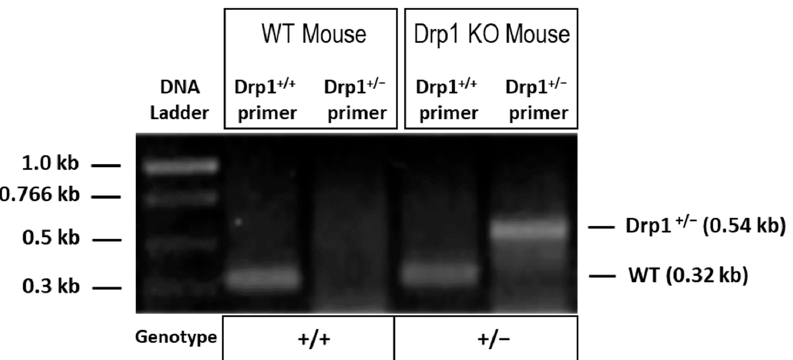
Figure 1. PCR analysis using mice tail tip DNA indicating genotypes of Drp1 heterozygous knockout ( +/ − ) and wild-type (WT) mice. The wild-type Drp1 allele (Drp1 +/+ ) is represented by a band at 0.32 kb, whereas the disrupted allele (Drp1 +/ − ) shows a band at 0.54 kb. 3.2. Effect of Diabetes on Drp1 Expression and Distribution in Retinal Capillary Networks